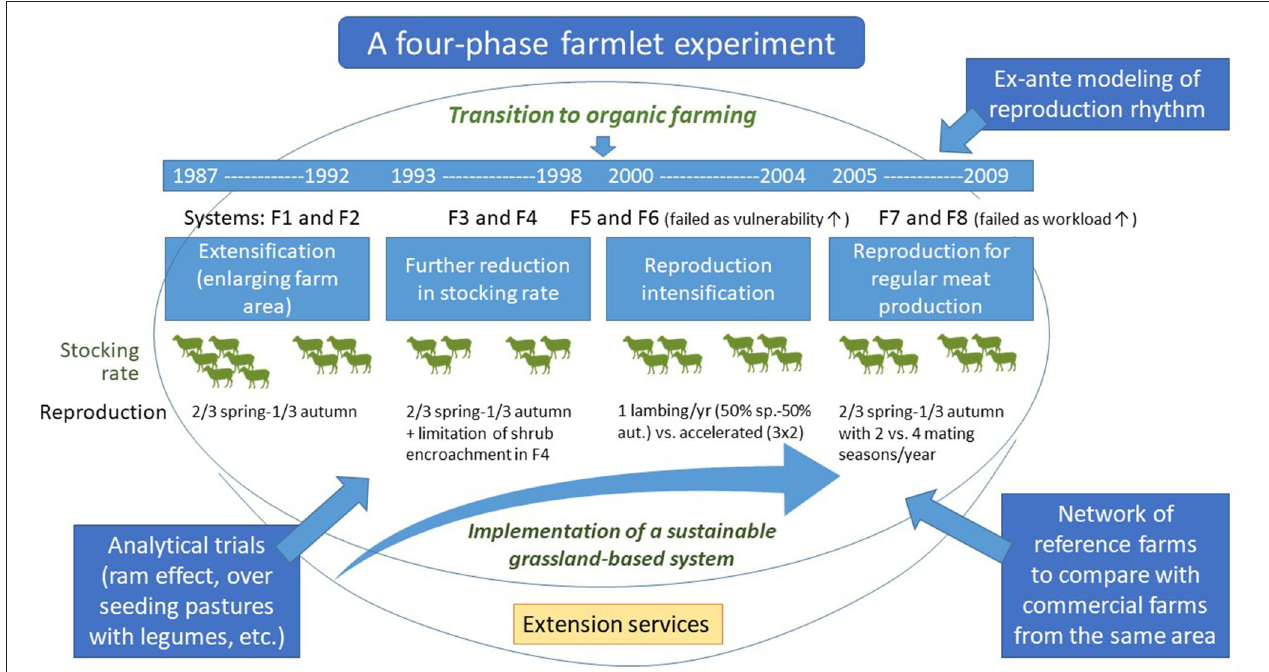
FIGURE 2 | The four successive cycles of farmlet experiments that were conducted in French Massif Central to design a self-sufficient and sustainable system for upland sheep production.